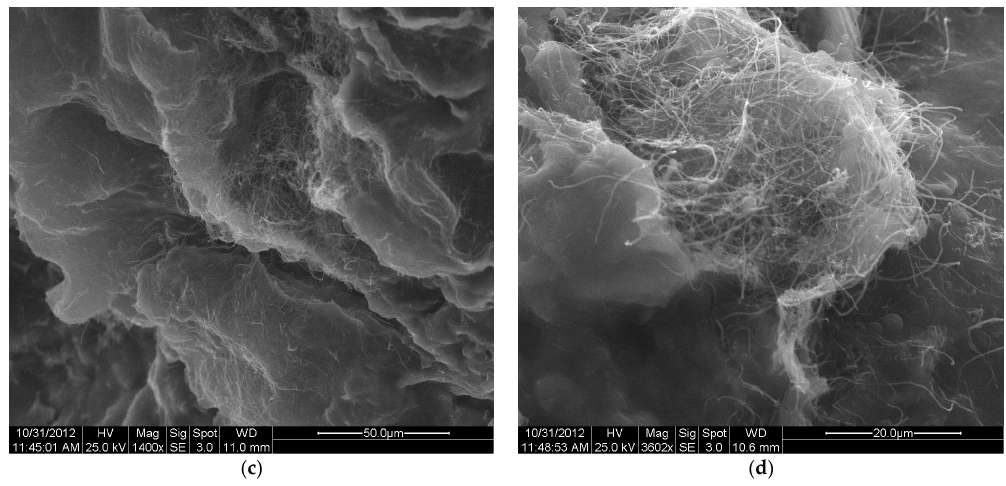
Figure 4. SEM images showing Sodium Algenate microstructure for the various synthesized % of Functional CNTs: ( a ) Sodium alginate sheets; ( b ) Functional CNT-sodium alginate conjugates (% of Functional CNTs = 50); ( c ) and ( d ) Functional CNT-sodium alginate conjugates (% of Functional CNTs = 17).